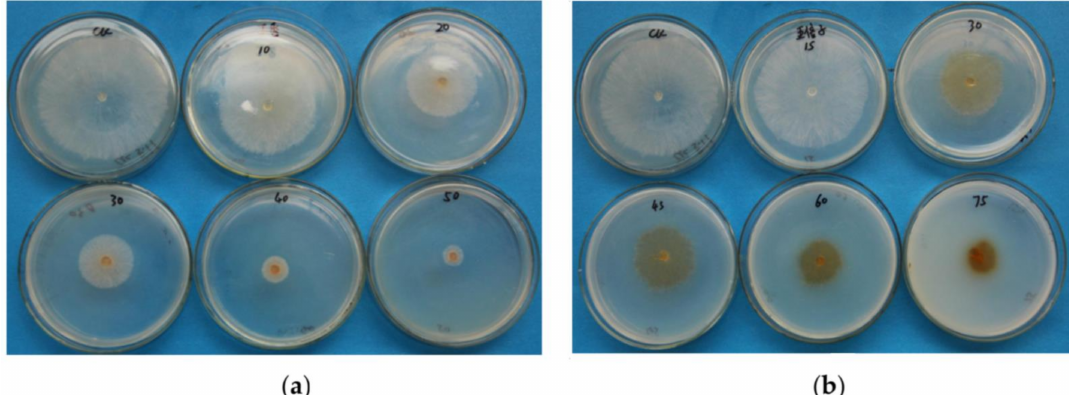
Figure 1. ( a ) The ethanol extracts from clove at concentrations from 10 to 50 µ g/mL; ( b ) the ethanol extracts from gallnut at concentrations from 15 to 75 µ g/mL.